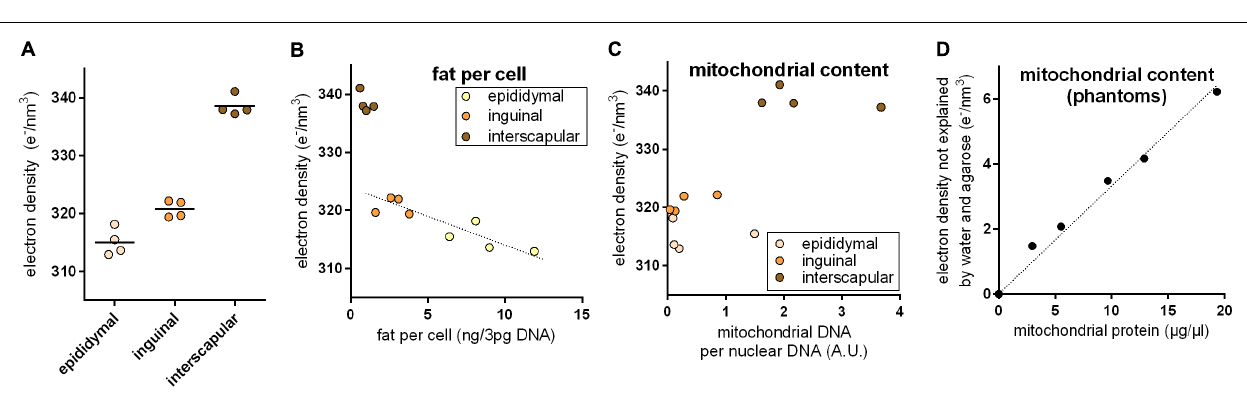
adipocyte of 50 µ m diameter (for comparison: a 50 µ m diameter sphere of water weighs 65.5